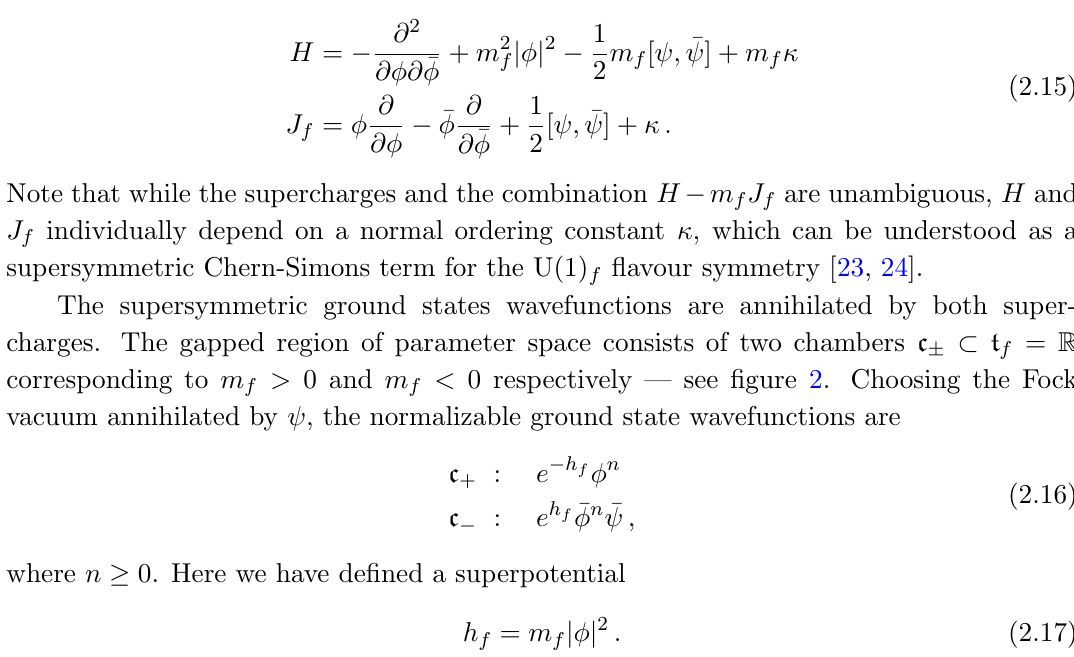
+ = f m f > 0 g and c